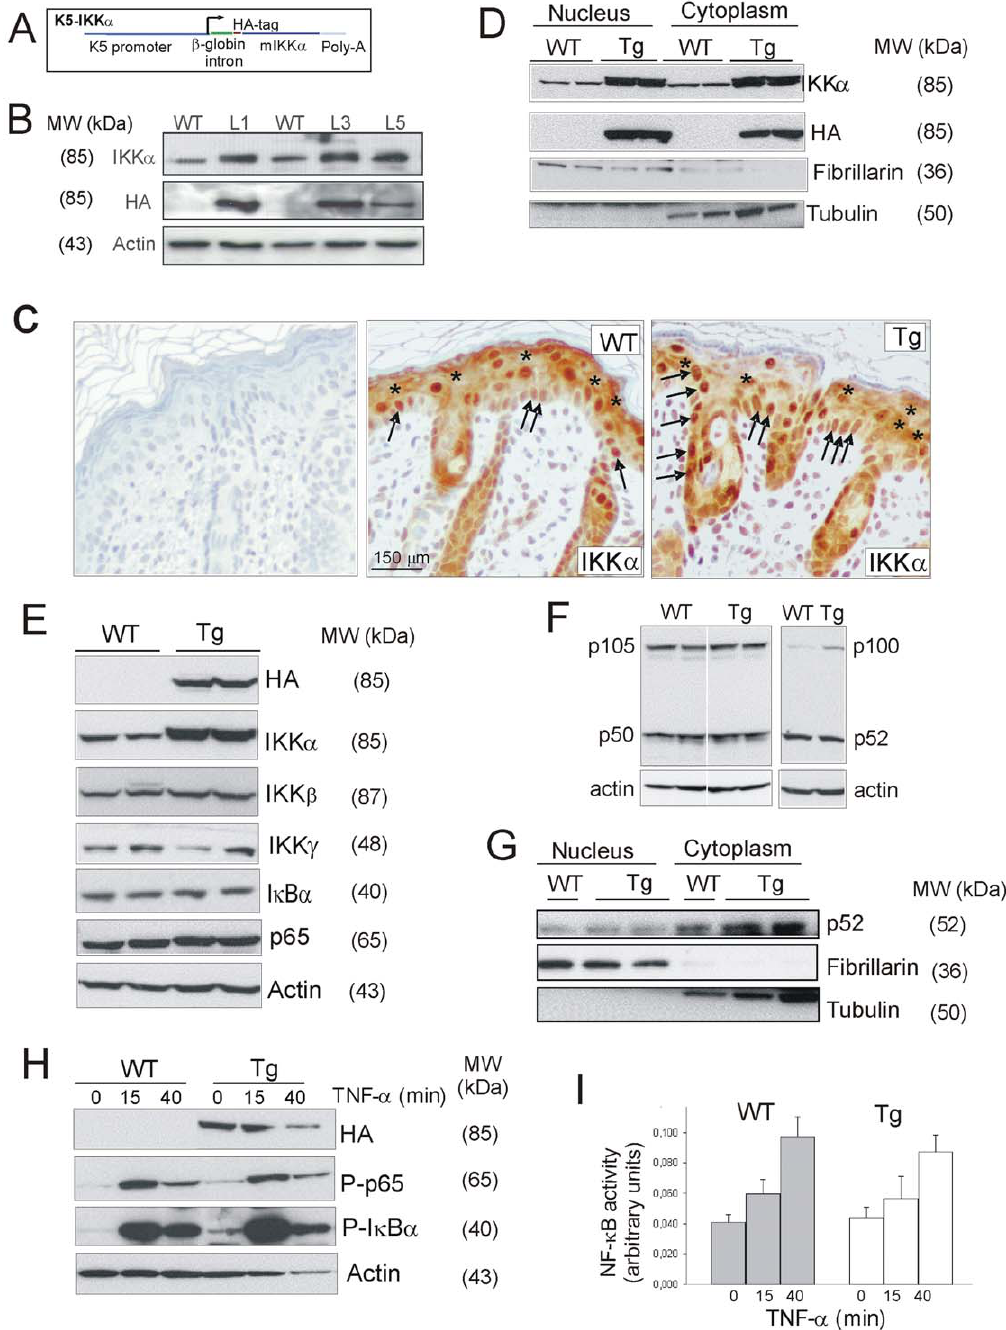
Figure 1. Characterization of K5-IKK a transgenic mice. ( A ) Recombinant DNA construct employed to generate transgenic mice. ( B ) Western blots showing IKK a and HA expression in WT and 3 different transgenic lines (L1, L3 and L5). Actin was used as a loading control. ( C ) Expression of the IKK a protein in back skin of 3-day-old mice. Immunostaining with the Sc-7182 antibody is showed (middle and right panels); similar results where obtained with the IMG-90454 anti IKK a antibody (not shown). Control without primary antibody (only with secondary biotinylated anti-rabbit antibody) is shown as control of specificity of the immunostaining against IKK a (left panel). Arrows show the expression of IKK a in basal epidermal keratinocytes and hair follicles. Asterisks indicate cytoplasmic expression of IKK a . ( D ) IKK a and HA detection in nuclear and cytoplasmic protein extracts from 5 day-old WT and Tg mice. Samples from two different mice of the line L1 and two different control littermates were loaded. Fibrillarin and tubulin show loading control and purity of the extracts. ( E ) Western blots analysis of the expression of different members of the NF- k B pathway in skin of WT and K5-IKK a transgenic mice. Total proteins from backskin of two different mice of the line L1 and two different control littermates were loaded. No differences were found between mice of both genotypes. ( F ) Western blot showing p100 and p105 processing in skin of WT and Tg mice. No differences were found. ( G ) Western blot showing the nuclear localization of p52 in skin of WT and Tg mice. No differences were found. ( H ) p65 and I k B a phosphorylation kinetics; actin: loading control. Newborn WT and Tg mice were injected with TNF- a and analyzed at the indicated times. ( I ) NF- k B activity in skin of non-stimulated and TNF- a injected mice for the indicated times. Experiments were repeated 3 times with similar results.